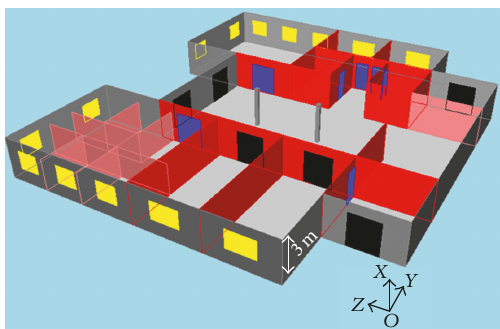
Figure 3: 3D construction plan of the first floor of the north wing of the